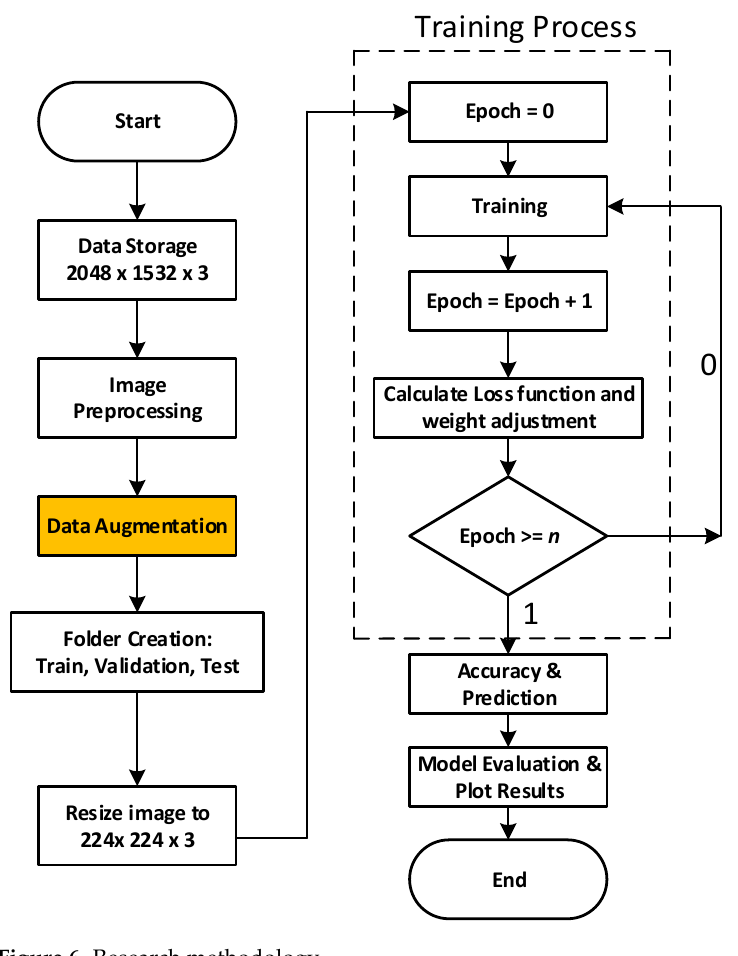
Figure 6. Research